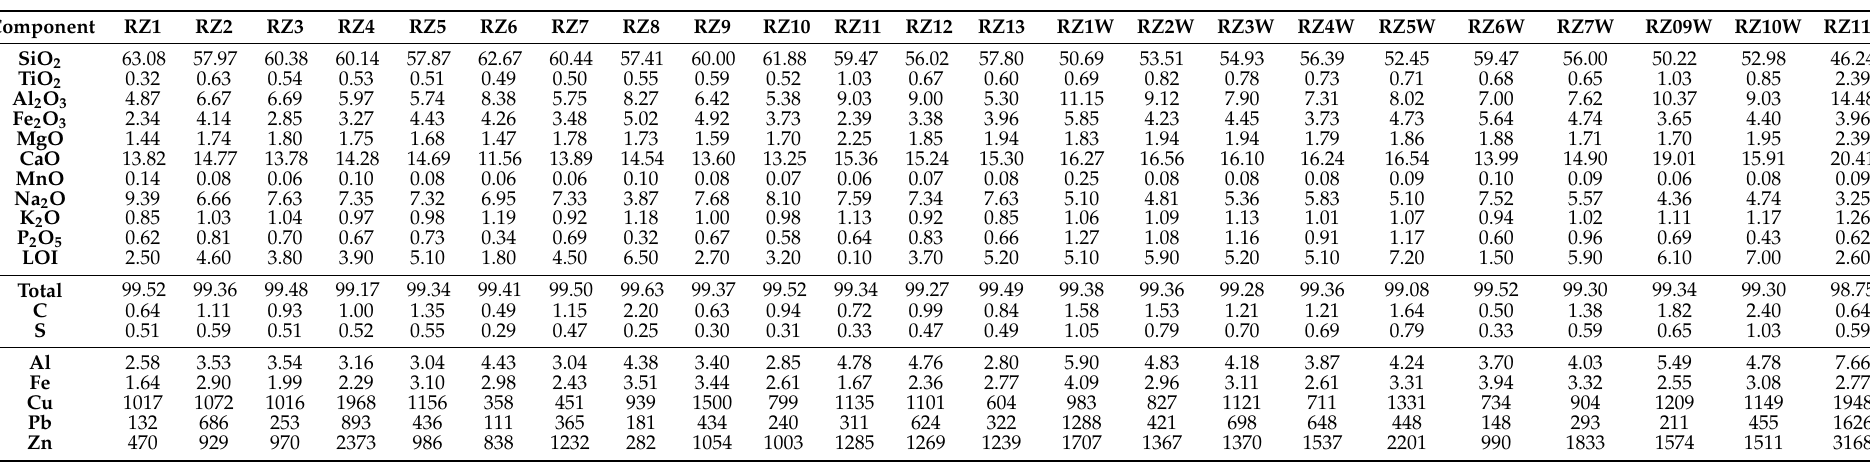
Table 2. Chemical composition of BA samples (content of all components in wt%; except for Cu, Zn, and Pb, in mgkg − 1 ; LOI—loss of ignition; samples’ symbols—see Table